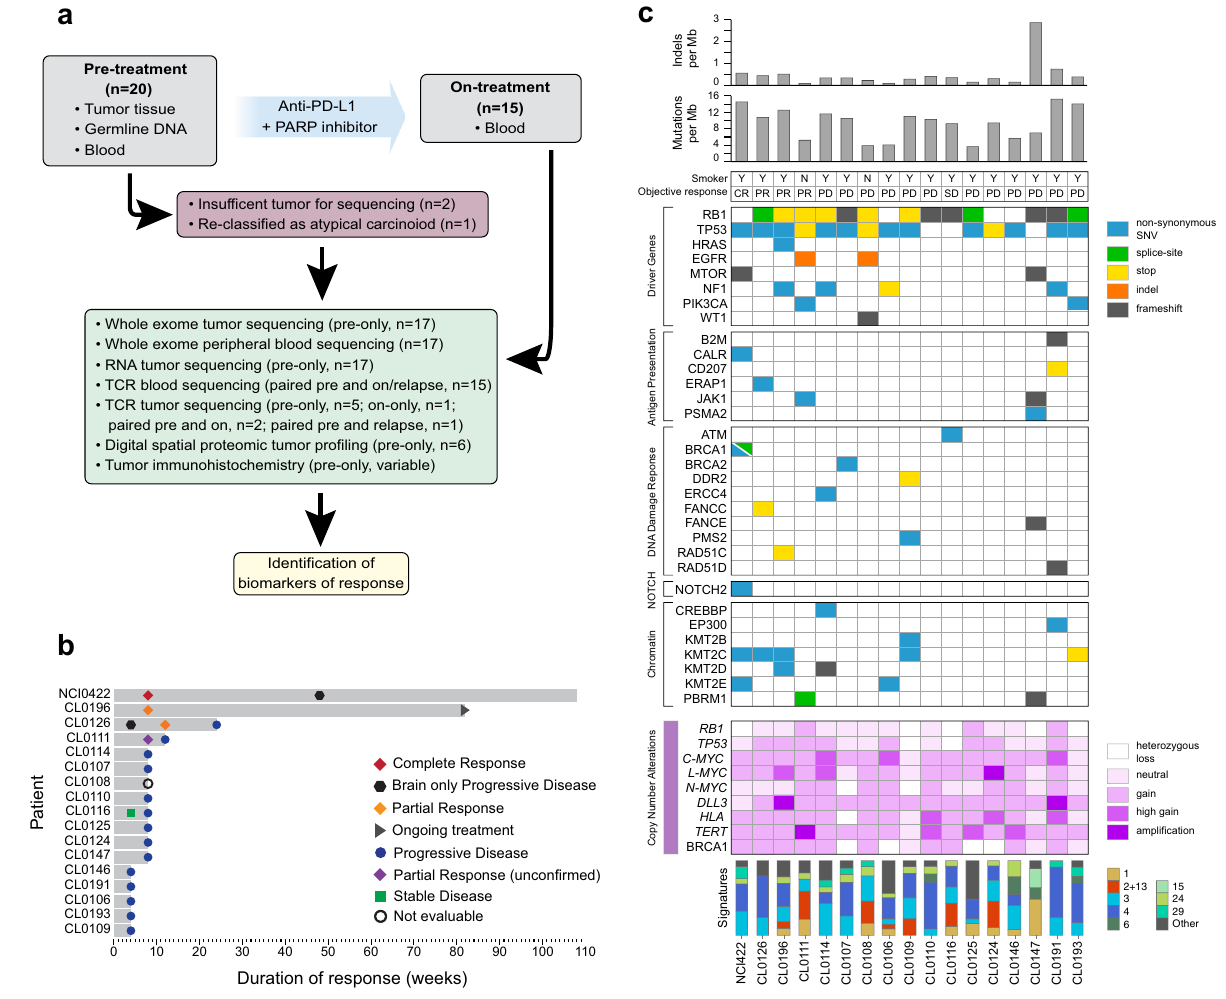
Fig. 1 Study design, clinical characteristics, and whole exome sequencing summary results of the relapsed small cell lung cancer discovery cohort. a Schematic representation of the clinical trial of combination immune checkpoint blockade (PD-L1 inhibitor plus PARP inhibitor) and sample analysis. Tumor samples were collected prior to treatment and analyzed using whole exome sequencing, RNA sequencing, digital spatial pro fi ling, and immunohistochemistry. T-cell receptor sequencing was performed on pre- and on-treatment blood samples, and on select tumors, where available. b Swimmer plot indicating response and length of time on therapy for individual patients. Timing of responses are also indicated. c Heatmap summarizing mutation burden, mutational signatures, somatic variants and copy number alterations derived from whole exome sequencing of patient tumors. Smoking status and best response for each patient are also shown. Source data are provided as a Source Data fi